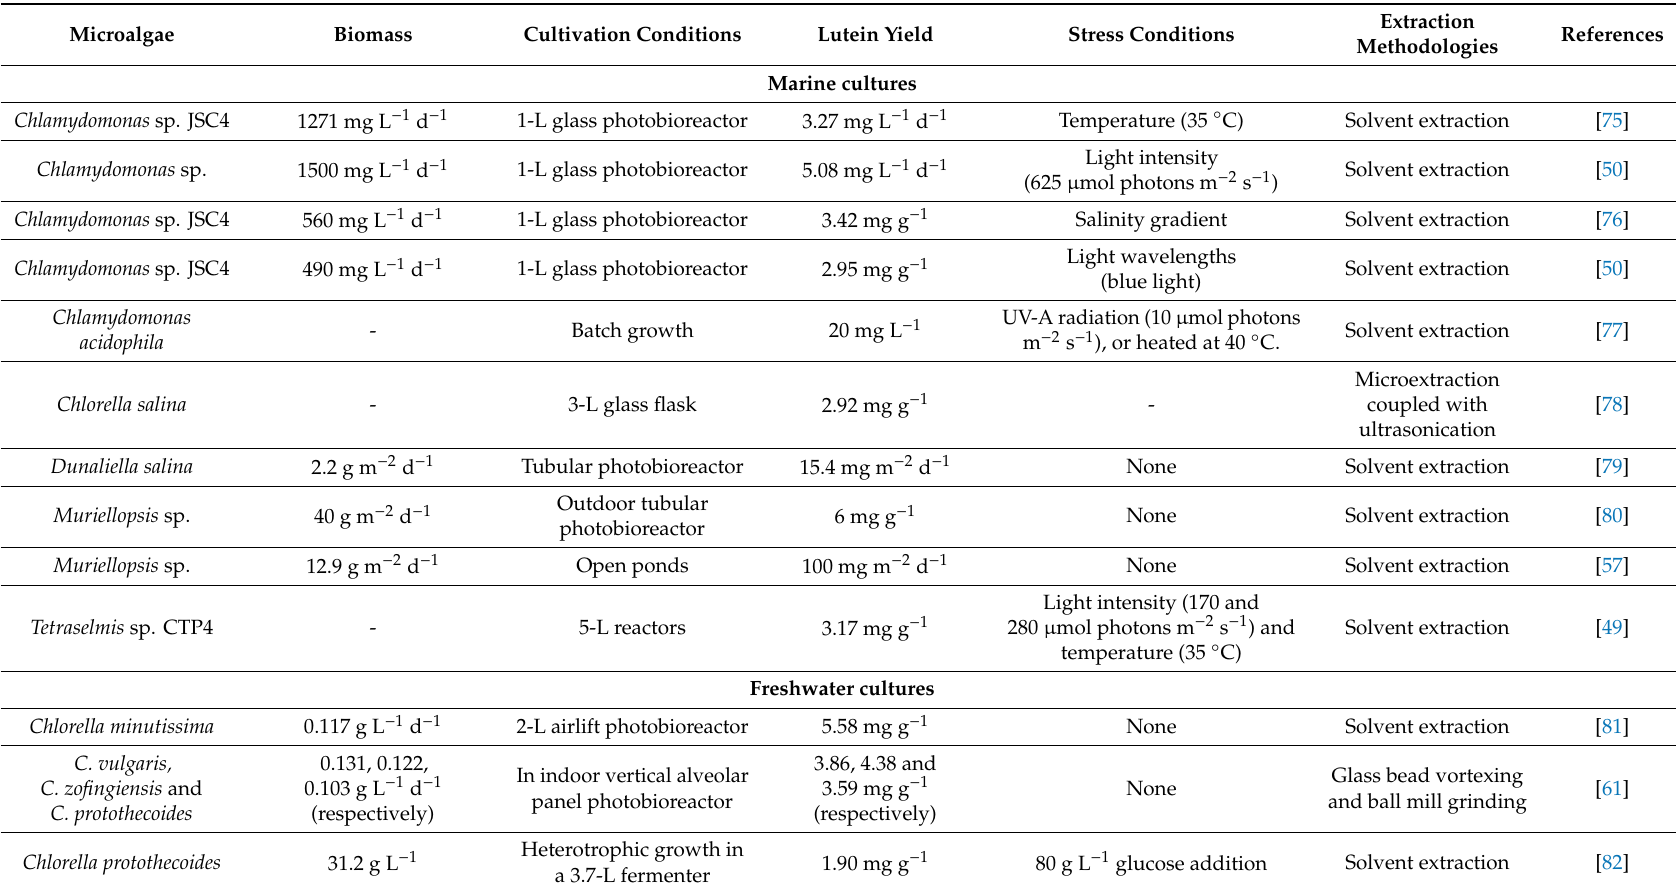
Table 1. List of lutein-producing microalgae and their lutein yield associated with tested cultivation and stress